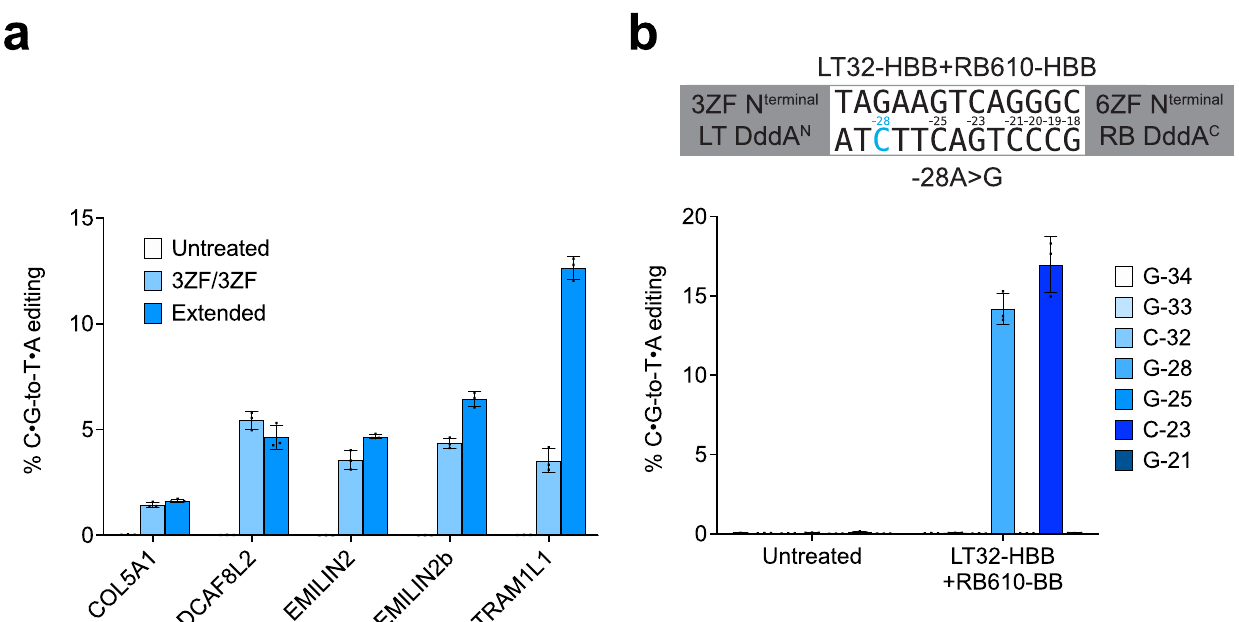
Fig. 5 | ZF-DdCBEs enable base editing of nuclear DNA. a Nuclear DNA base editingef fi cienciesofHEK293Tcellstreatedwith fi ve3ZF+3ZFnuclear-targetedZF- DdCBE pairs, or ZF-DdCBE variants with extended ZF arrays. ZF-DdCBE pairs were designedtoinstalleditswithinornearbynucleargenes COL5A1 , DCAF8L2 , EMILIN2 , EMILIN2 ,and TRAM1L1 ,respectively.Theeditingef fi cienciesshownareforthemost ef fi ciently edited C (cid:129) G within the spacing region. b Nuclear DNA base editing